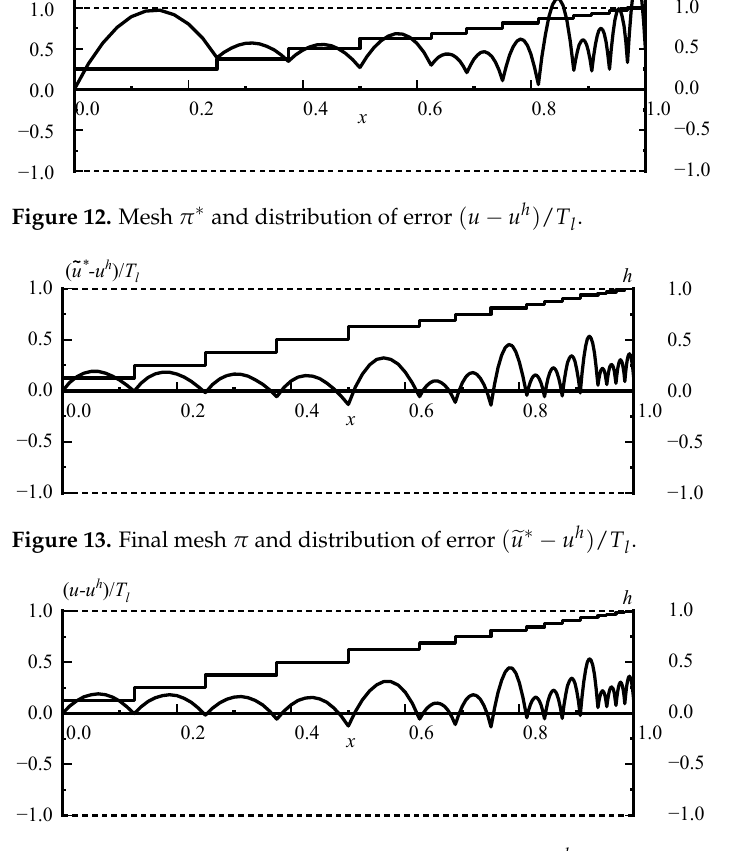
Figure 14. Final mesh π and distribution of error ( u − u h ) / T